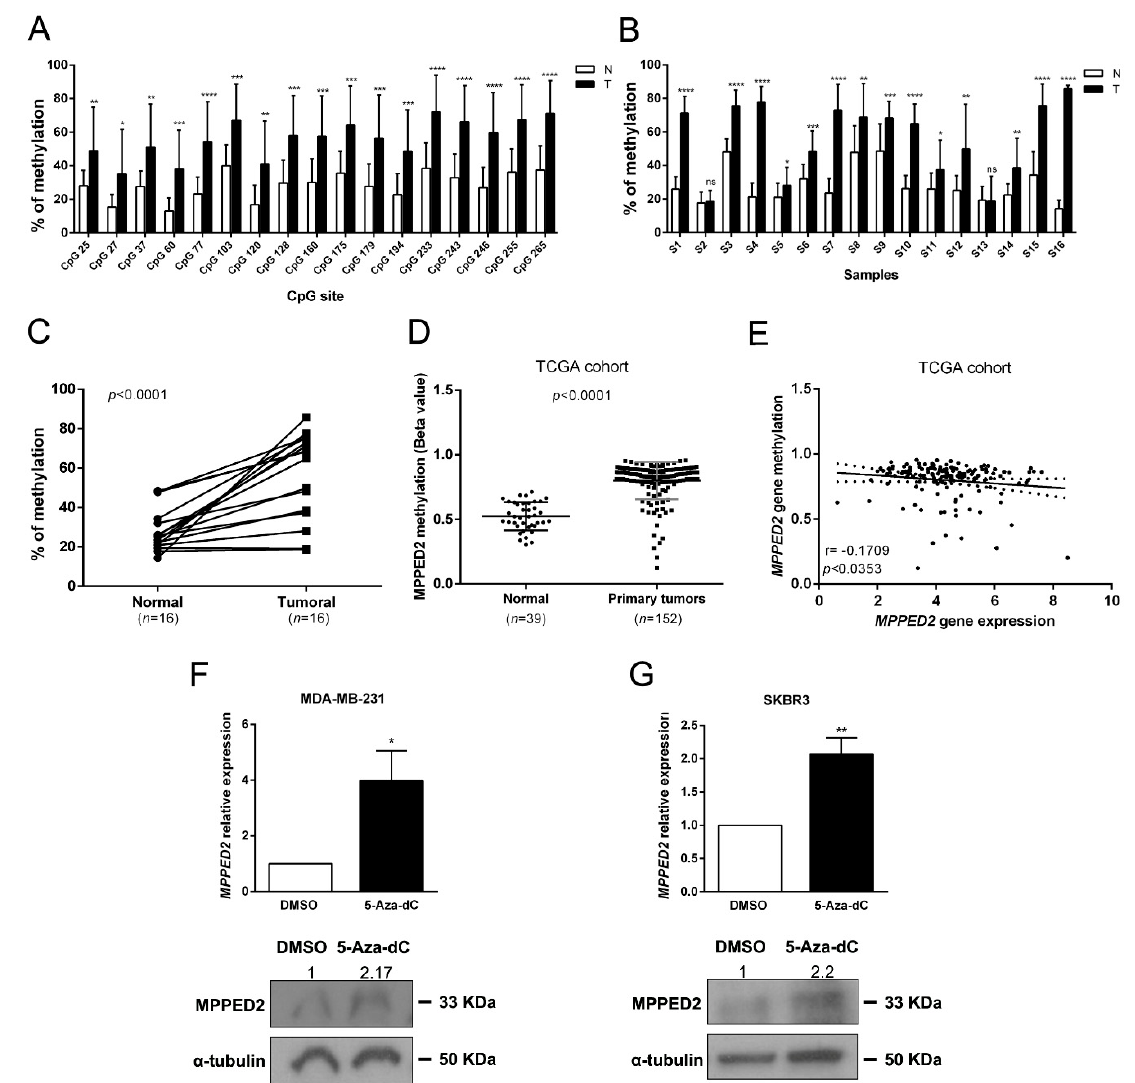
Figure 3. MPPED2 methylation status in normal and tumoral samples. ( A ) Methylation levels of CpG sites in the MPPED2 promoter. Each histogram represents the mean value of each CpG site in the whole cohort analyzed. White and black bars represent normal and breast cancer tissues, respectively.